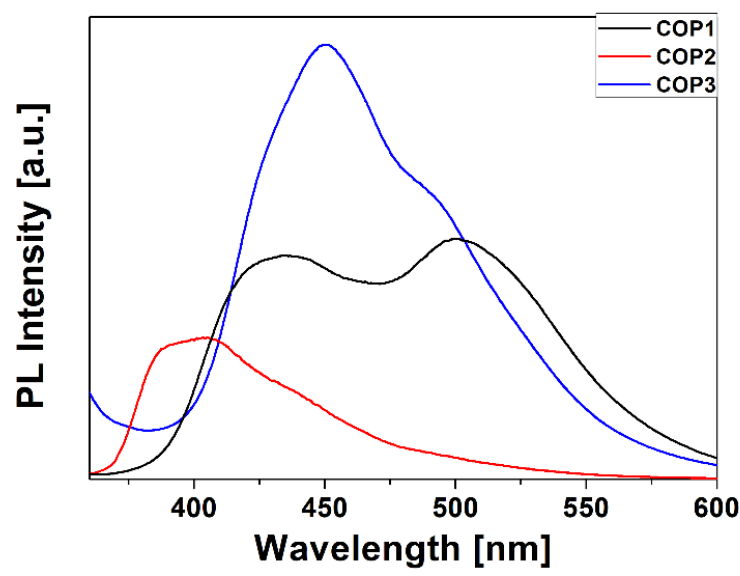
Figure 3. Photoluminescence spectra of styrylquinoline copolymers ( λ ex. = 340 nm).